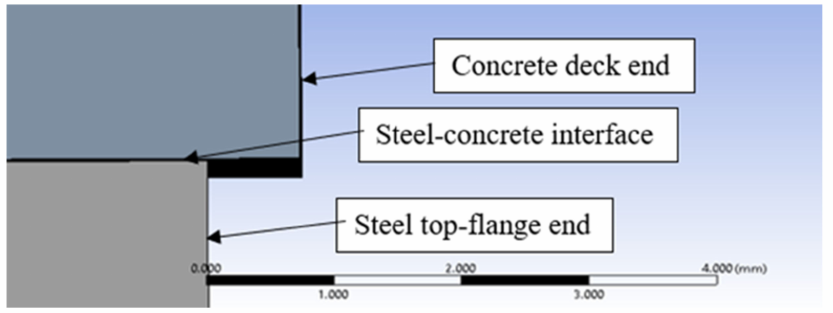
Figure 7. Relative slippage between the steel beam and concrete deck at the composite beam